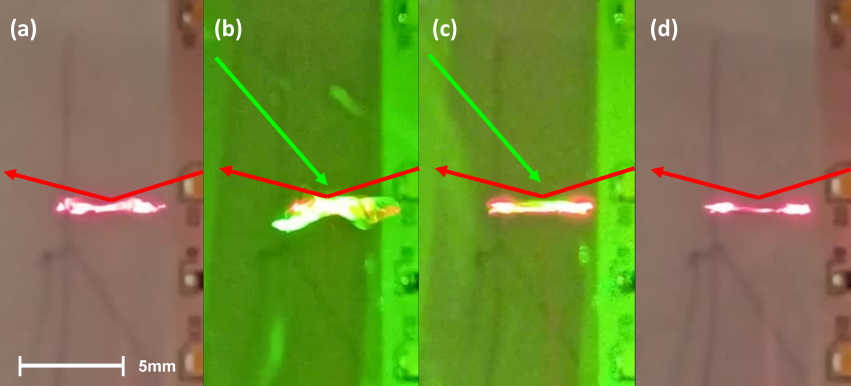
Figure 2. A sequence showing four different states of an irregular shaped PMP film during its rotational motion. The red and green arrows show the probe and pumping laser beams, respectively. In ( a ), the sample rotates in an irregular way; in ( b ), the external perturbation hits the sample, inducing a transient irregular motion; in ( c ), the motion is stabilized; and in ( d ), the sample remains in the more stable conformation for a time before returning to the same state as in ( a